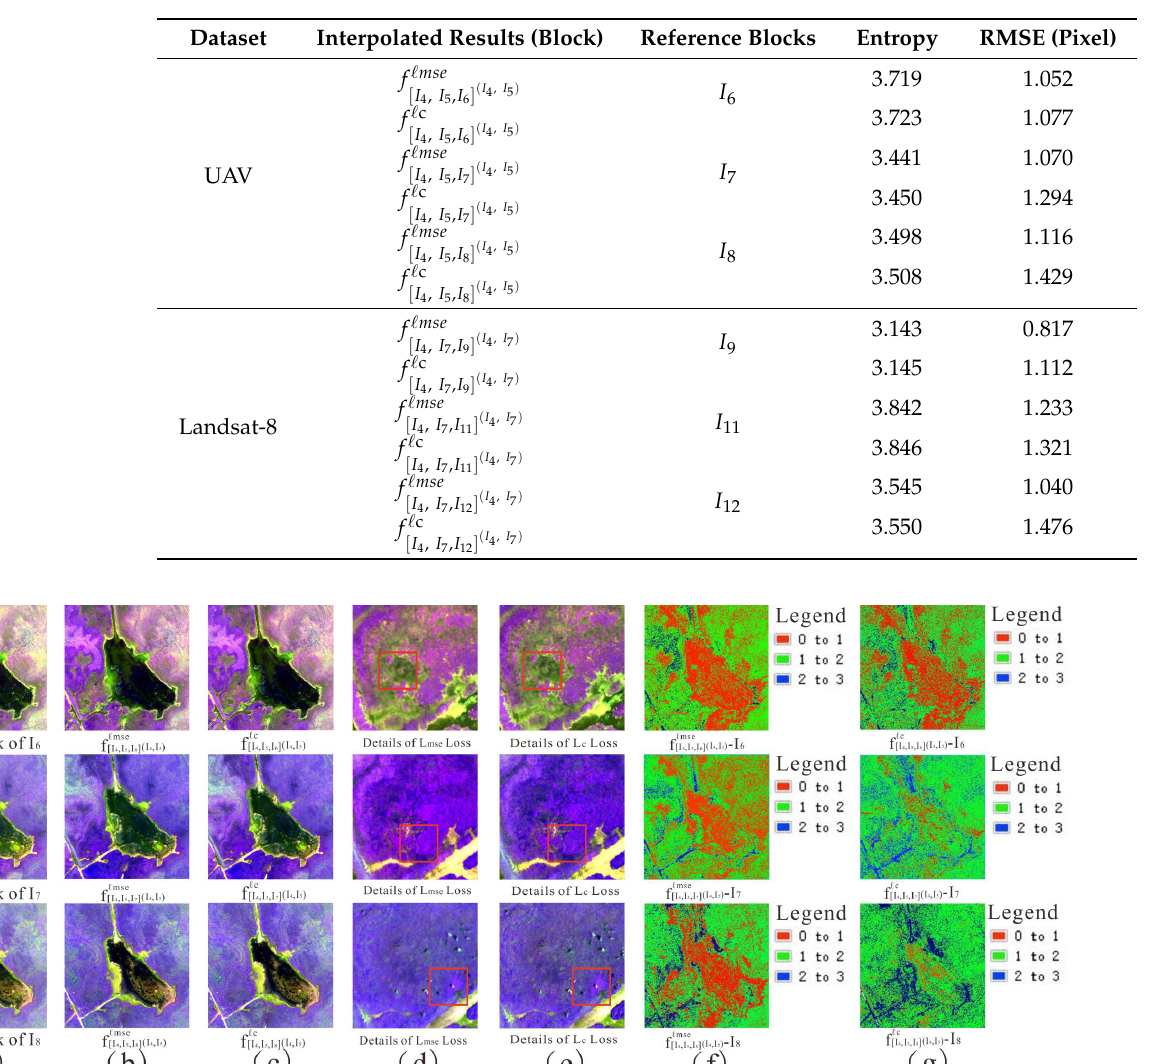
Table 3. Quantitative evaluation between block interpolated result and reference block using our proposed method on both datasets.